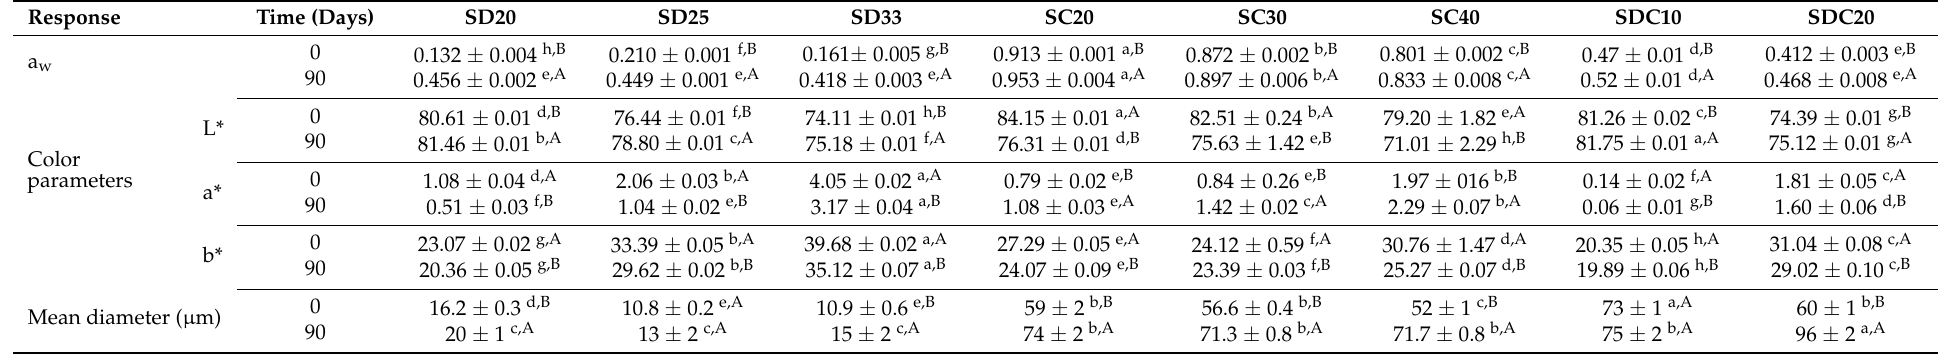
Table 2. Characterization of microparticles produced by spray drying (SD), chilling (SC), and their combination (SDC) before and after